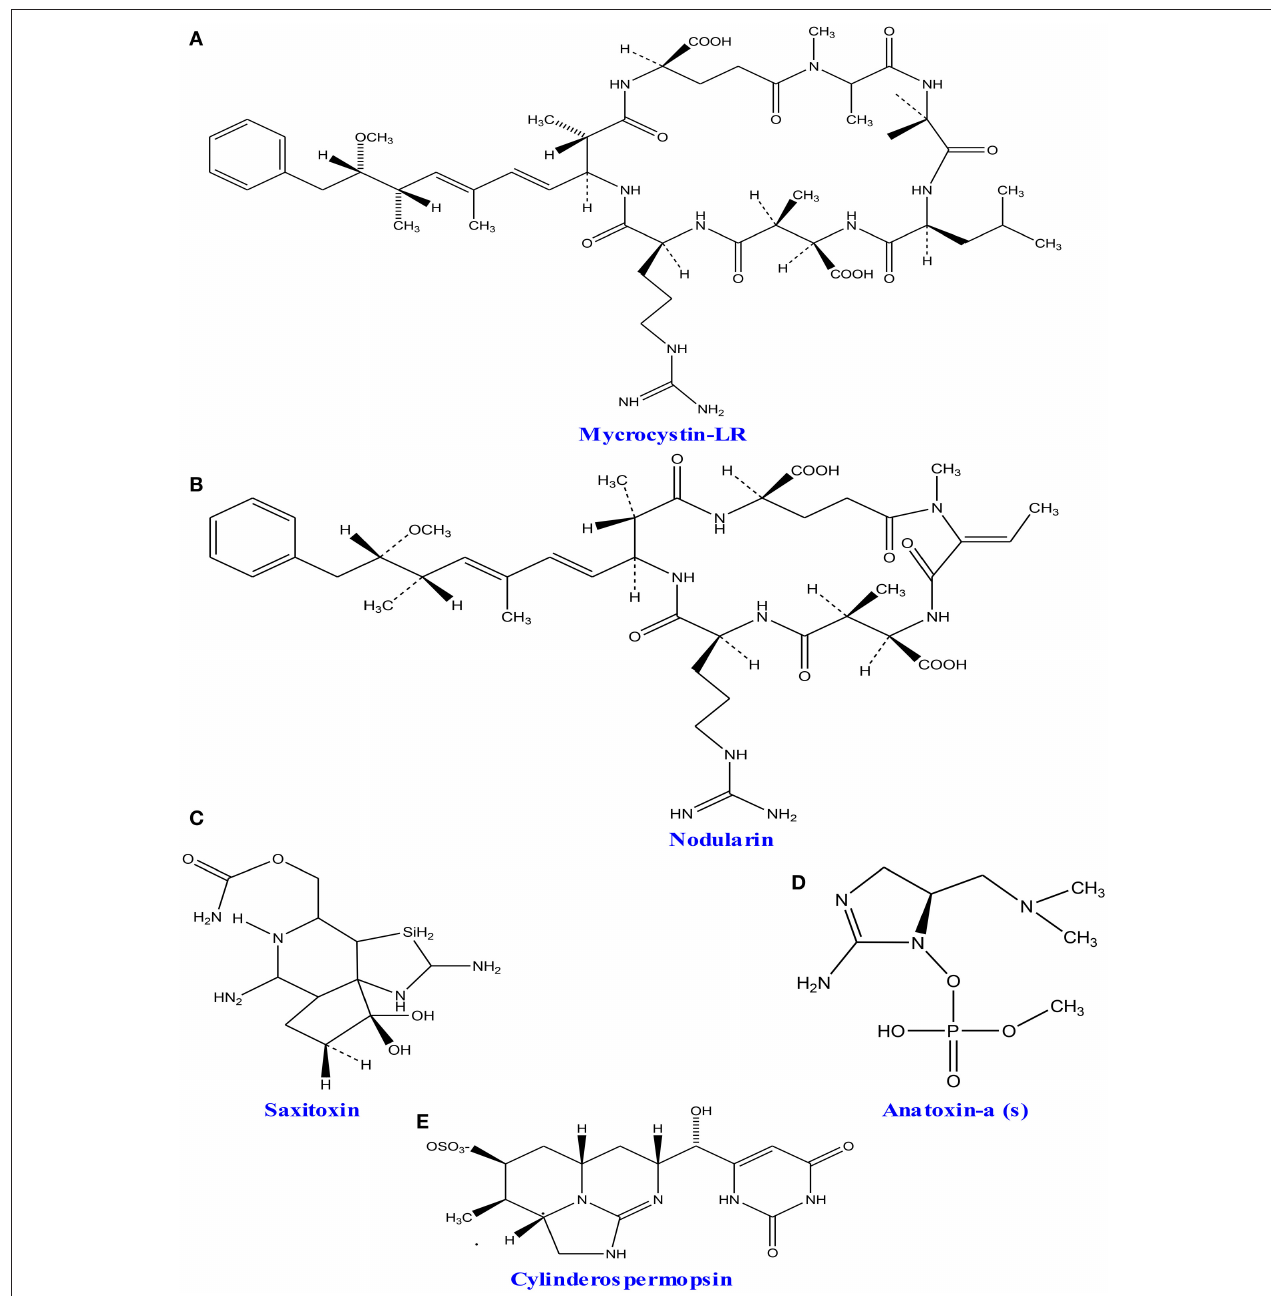
FIGURE 7 | Chemical structures of cyanotoxins: (A) microcystin-LR, (B) nodularin, (C) saxitoxin (D) anatoxin- a, and (E) cylinderosprmopsin obtained from different cyanobacteria.